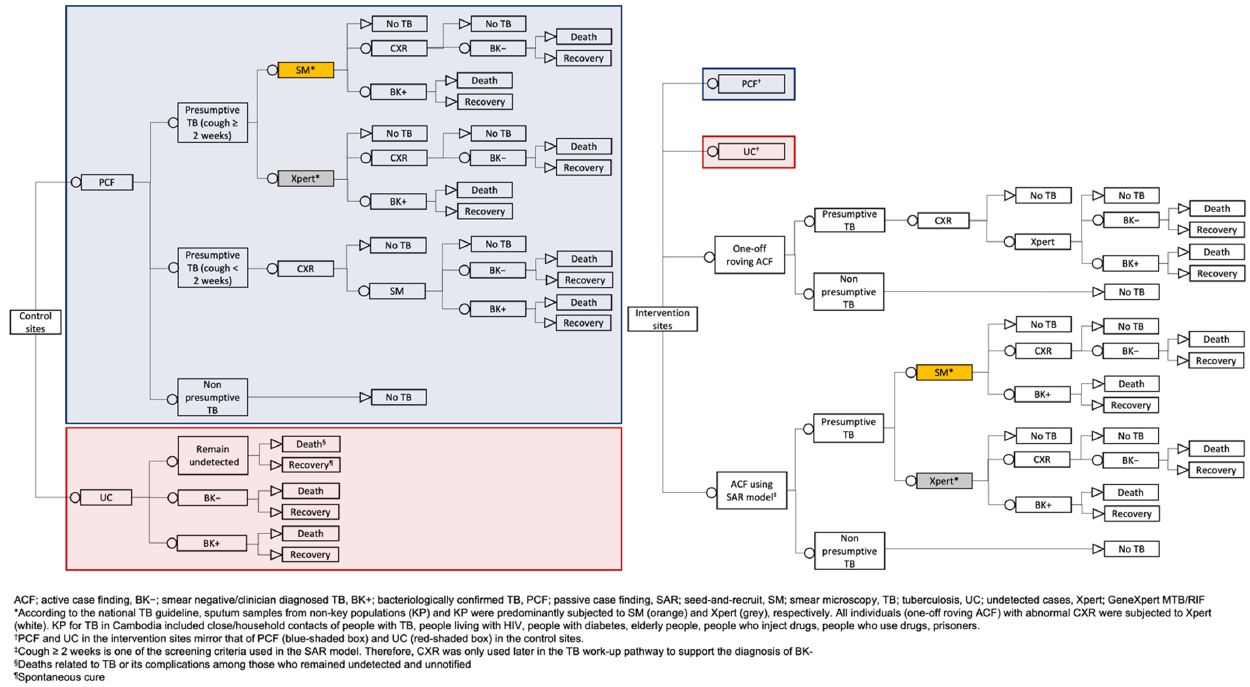
Figure 2. Decision tree for comparing the cost-effectiveness of ACF interventions (ACF using a seed-and-recruit model and one-off roving ACF) with control in 24 operational districts in Cambodia.